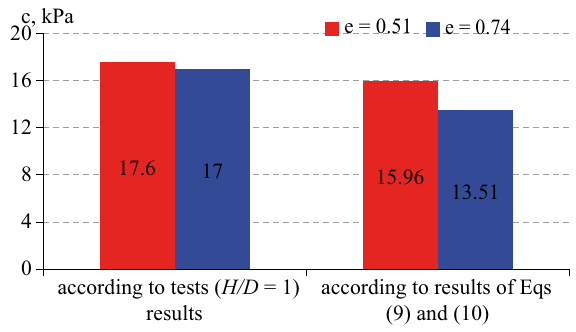
Fig. 17. Values of cohesion